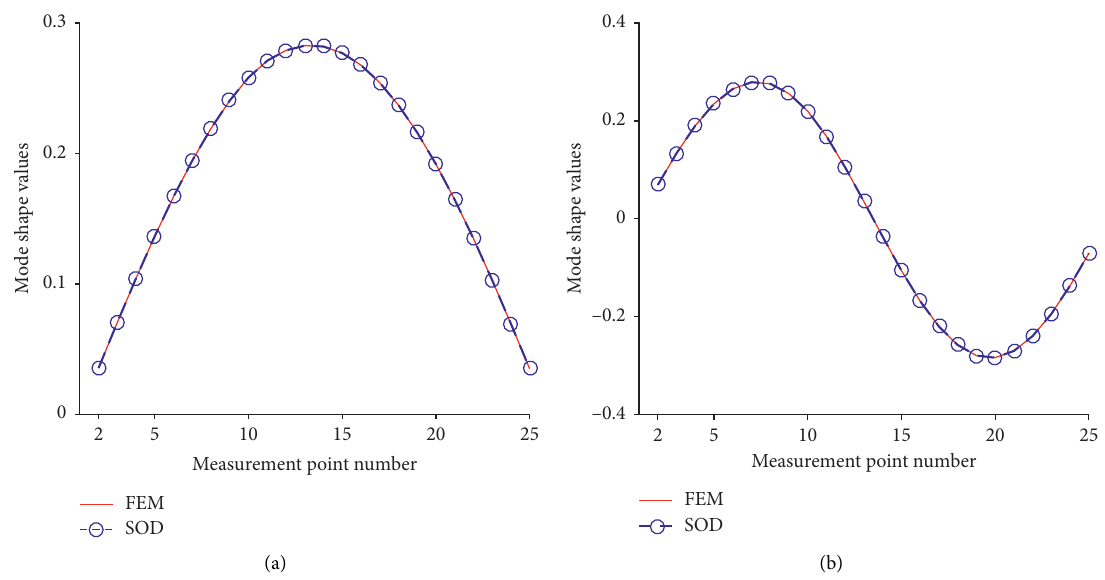
Figure 4: Mode shapes of a simply supported beam with single damage (0.5% for the noise level). (a) First mode. (b) Second mode.